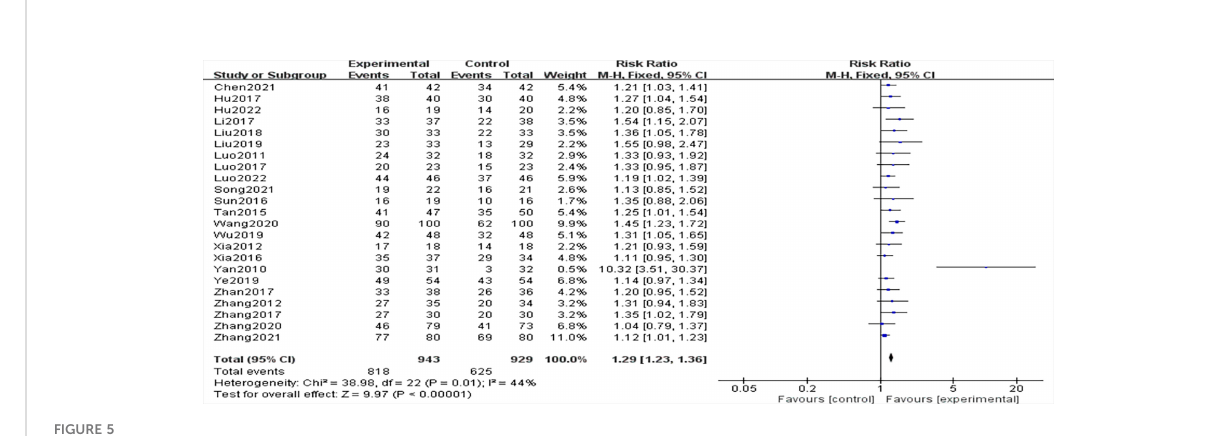
FIGURE 5 Forest plot of total ef fi ciency rate